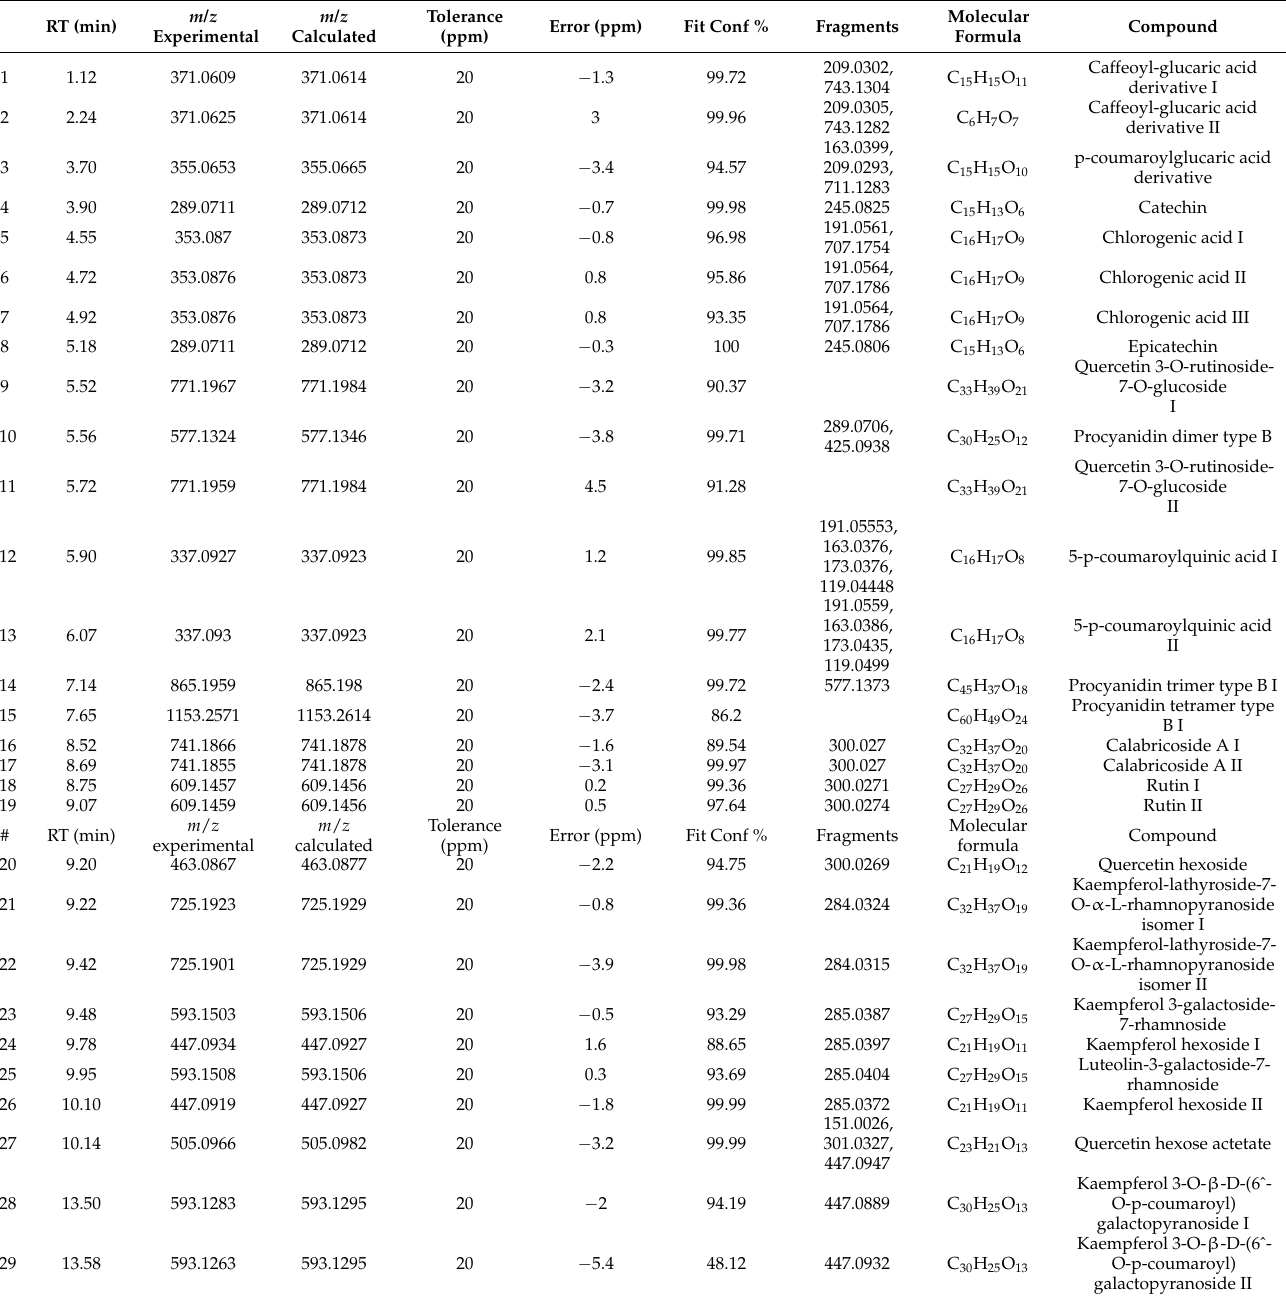
Table 1. Identification table of phenolic compounds in cherimoya leaves obtained at UAE sonotrode